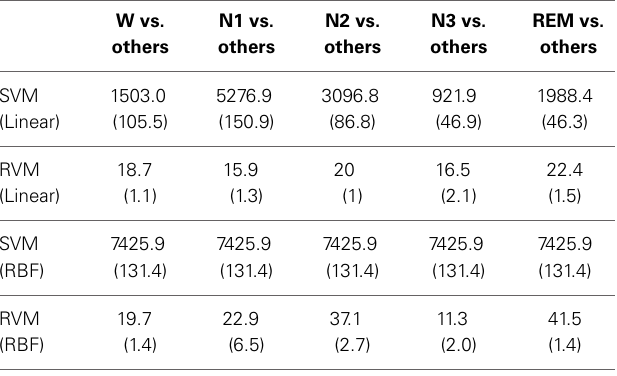
Table 5 | Number of support vectors in SVM and number of relevance vectors in RVM.